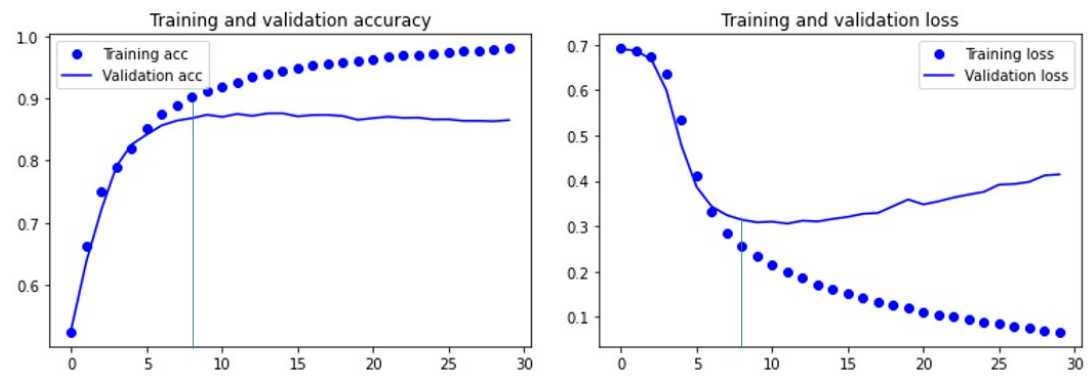
Figure 7. Structure diagram of convolutional neural network.